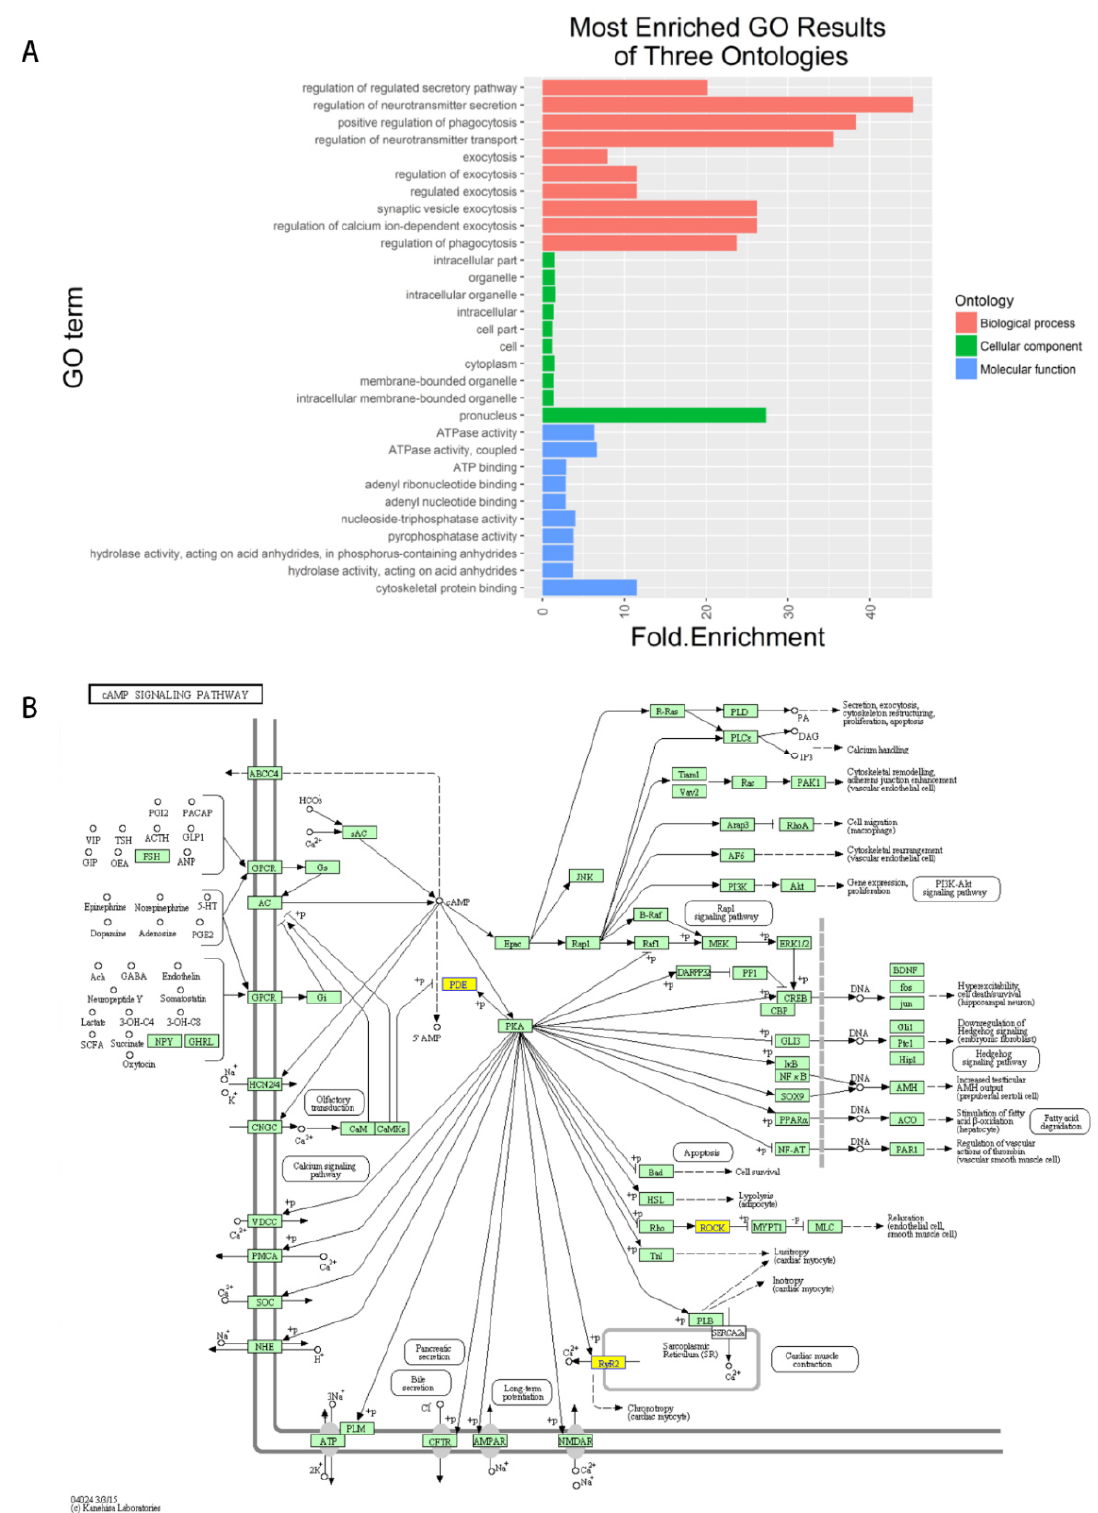
Figure 4. ( A ) Most enriched GO results expression circos. The horizontal axis is the number of significantly different genes, and the vertical axis is the top 10 significantly enriched GO terms. p < 0.05 was considered significant. ( B ) The upregulated pathway named cfa04024, where the orange boxes indicate the genes targeted by differentially expressed circRNAs. + : Phosphorylation. − : Dephosphor- ylation.